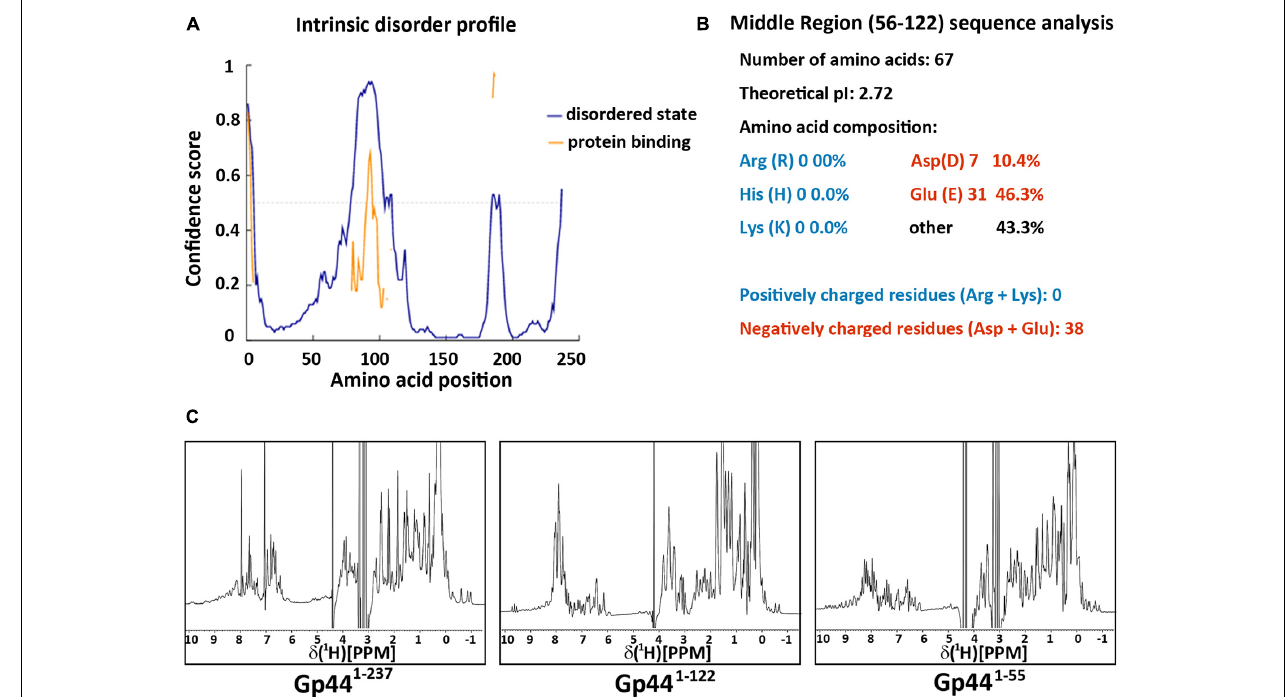
FIGURE 2 | Gp44 has three distinctive domains. (A) Intrinsic disorder profile predicted by DISOPRED. Blue line stands for the likelihood of protein in the natural disordered state and yellow line indicates the possibility of protein binding (B) Primary structure analysis of the middle disorder domain (56–122), including its ultra-low pI and extreme negative charged amino composition. (C) 1D 1 H spectra of three Gp44 constructs. From left to right: (Gp44 1 - 237 ), (Gp44 1 - 122 ), and (Gp44 1 - 55